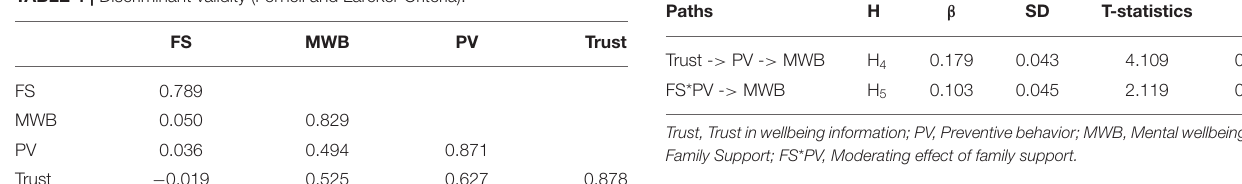
TABLE 4 | Discriminant validity (Fornell and Larcker Criteria).